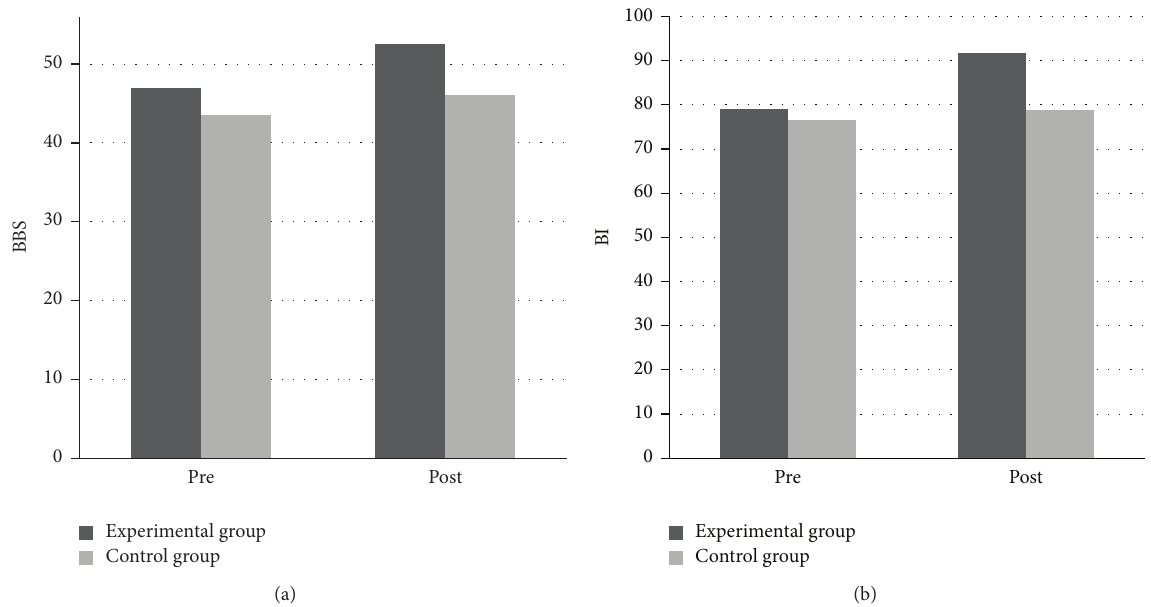
Figure 2: (a) and (b) show changes in the Berg Balance Scale (BBS) and Barthel Index (BI) scores, respectively (mean) between the groups at pre- and postassessment; dark grey bar (experimental group), light grey bar (control group). Significant improvements (increase in BBS and BI scores) were noted for both the measures at